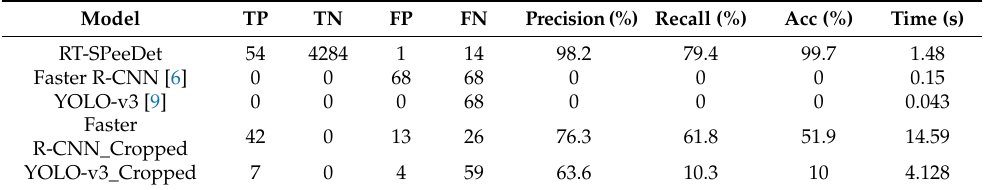
Table 3. Performance comparison of various object detectors with small pit defects